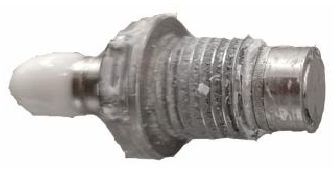
Figure 6. Pressure